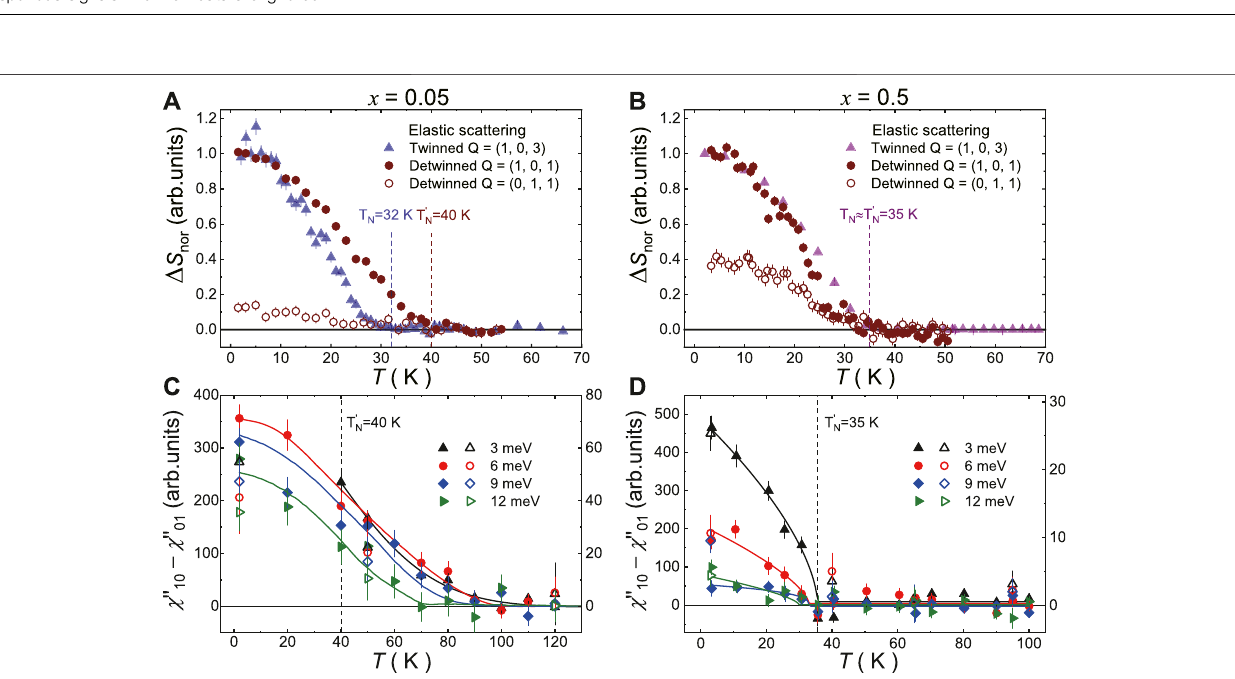
FIGURE 6 | (Color online) The order parameter of antiferromagnetism and spin nematicity χ 10 ″ − χ 01 ″ for x = 0.05 and x =0.5 compounds. (A) and (B) The magnetic orderparametersmeasuredat Q =(1,0,3)ontwinnedsamples, Q =(1,0,1)and Q =(0,1,1)ondetwinnedsamplesbyelasticneutronscattering.Alldataaresubtractedby thenormalstatebackgroundandnormalizedbytheintensityatbasetemperaturefor Q =(1,0,3)or Q =(1,0,1). (C) and (D) Spinnematicitymeasuredbyinelasticneutron scattering. The solid symbols are the differences of local susceptibility χ ′′ between Q = (1,0,1) and Q = (0,1,1) (left y -axis), and the open symbols are similar but obtained byintegrating theconstant-energy scansin Figure 5 corrected bytheBose populationfactor (right y -axis).Thevertical dash lines mark themagnetictransition temperature T N on twinned samples and T N ′ on detwinned samples. All solid lines are guides to eyes.